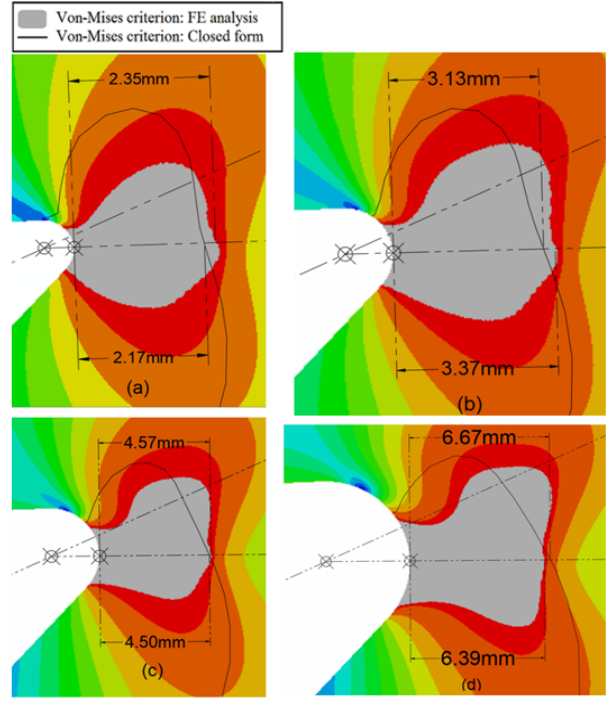
Figure 7. Plastic zones obtained from FE analyses and the proposed methodology based on the von Mises yield criterion, with notch tip radii of ( a ) 0.5 mm, ( b ) 1 mm, ( c ) 2 mm, and ( d ) 4 mm. Notch rotation angle = 25°. Applied loads were 35, 40, 44, and 48 kN, respectively.